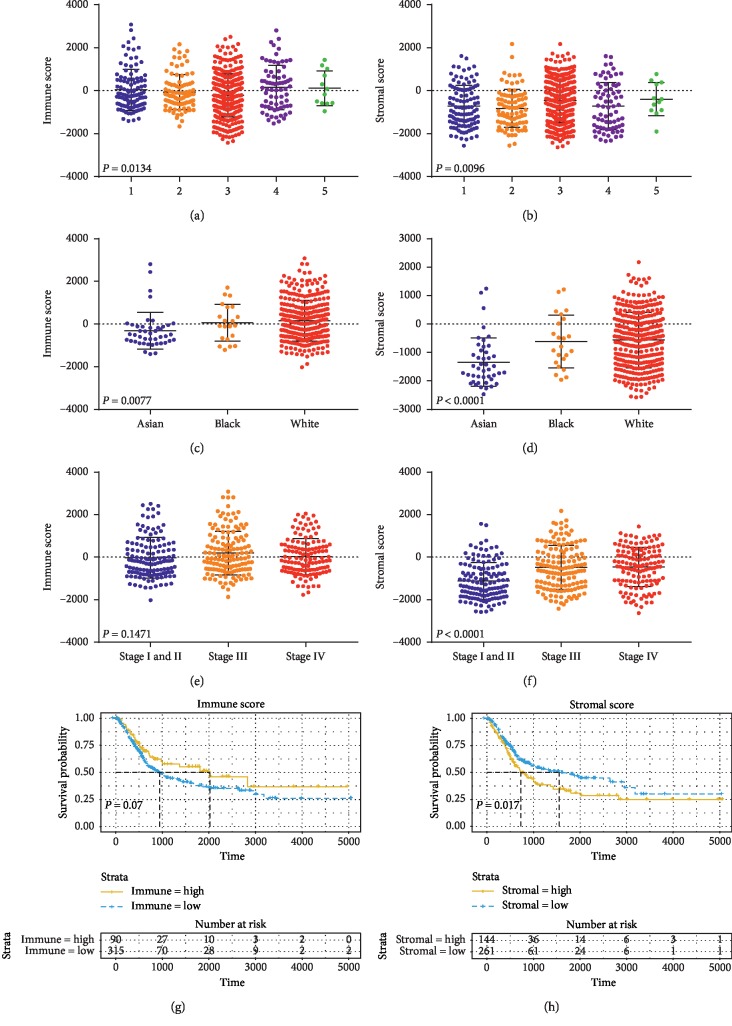
Immune scores and stromal scores are associated with smoking, race, the malignancy, and the survival probability. (A, B) Distribution of immune scores (a) and stromal scores (b) of different duration of cigarette smoking (n = 405, P < 0.05). (C, D) Distribution of immune scores (c) and stromal scores (d) for Asian, Black, and White race (n = 405, P < 0.05). (E, F) Distribution of immune scores (e) (n = 405, P=0.1471) and stromal scores (f) (n = 405, P < 0.05) of different degrees of malignancy cases. (G, H) Kaplan–Meier curves for survival probability of bladder cancer patients with low versus high immune scores (g) (n = 405, P=0.07) and stromal scores (h) (n = 405, P < 0.05).